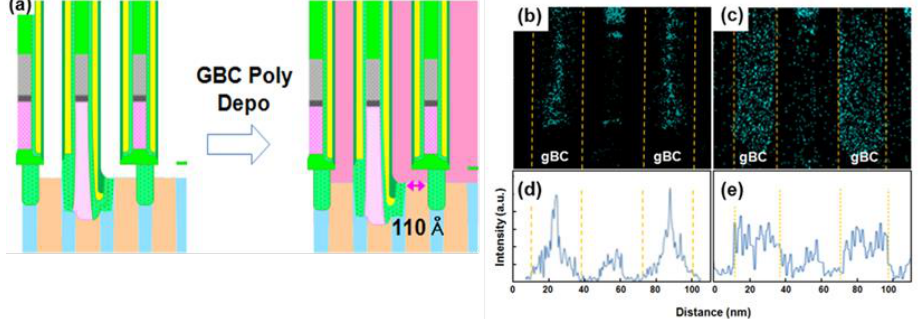
Figure 6. Energy dispersive spectroscopy (EDS) 2D profiles and line profiles of P doping concentration in the Si grown by ( a ) the gBC L-shaped profile, ( b , d ) thermal CVD, and ( c , e ) MW-CVD in the gBC pattern.